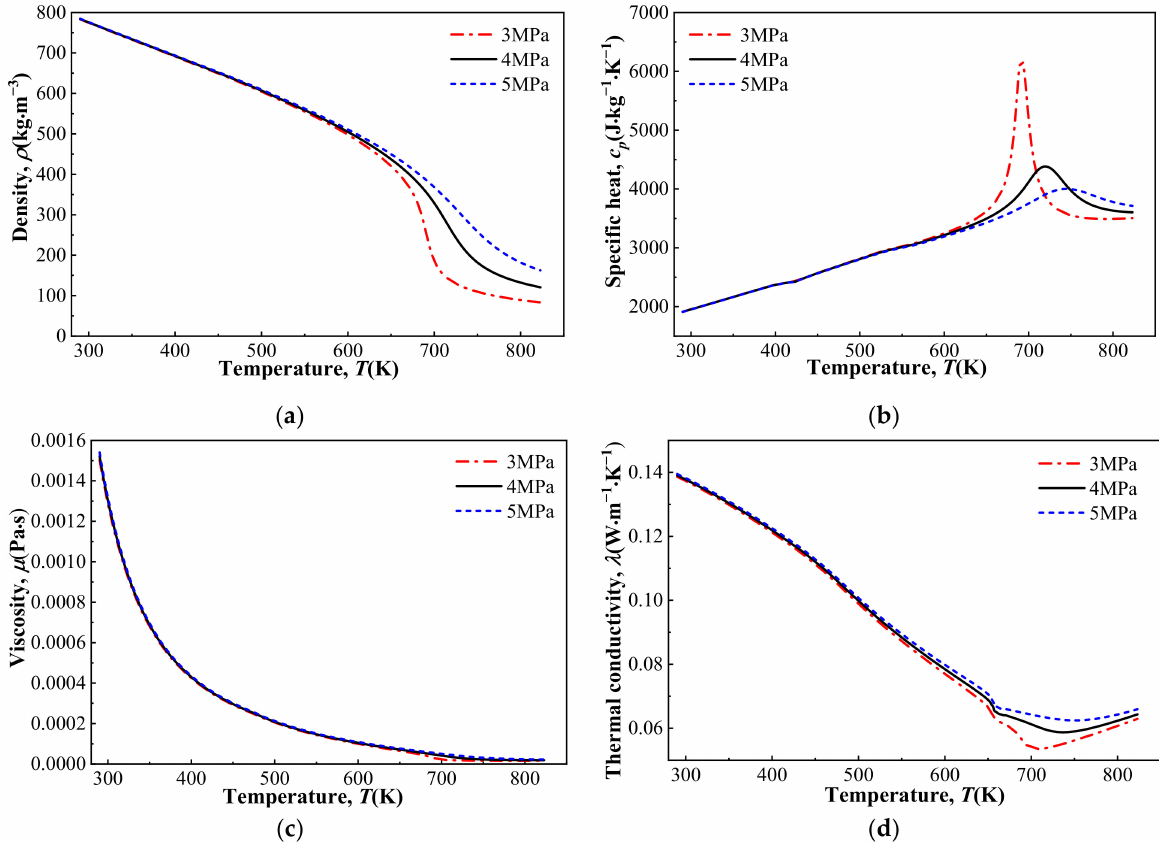
Figure 5. Thermophysical properties of 10-component kerosene as function of temperature at supercritical pressures: ( a ) Density ( b ) Specific heat ( c ) Viscosity ( d ) Thermal